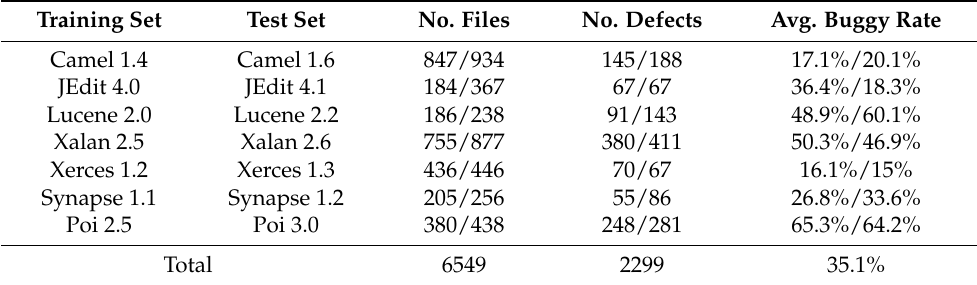
Table 1. CVPSC dataset description. The number of files, number of defects, and average buggy rate are listed separately for the training set and the test set.